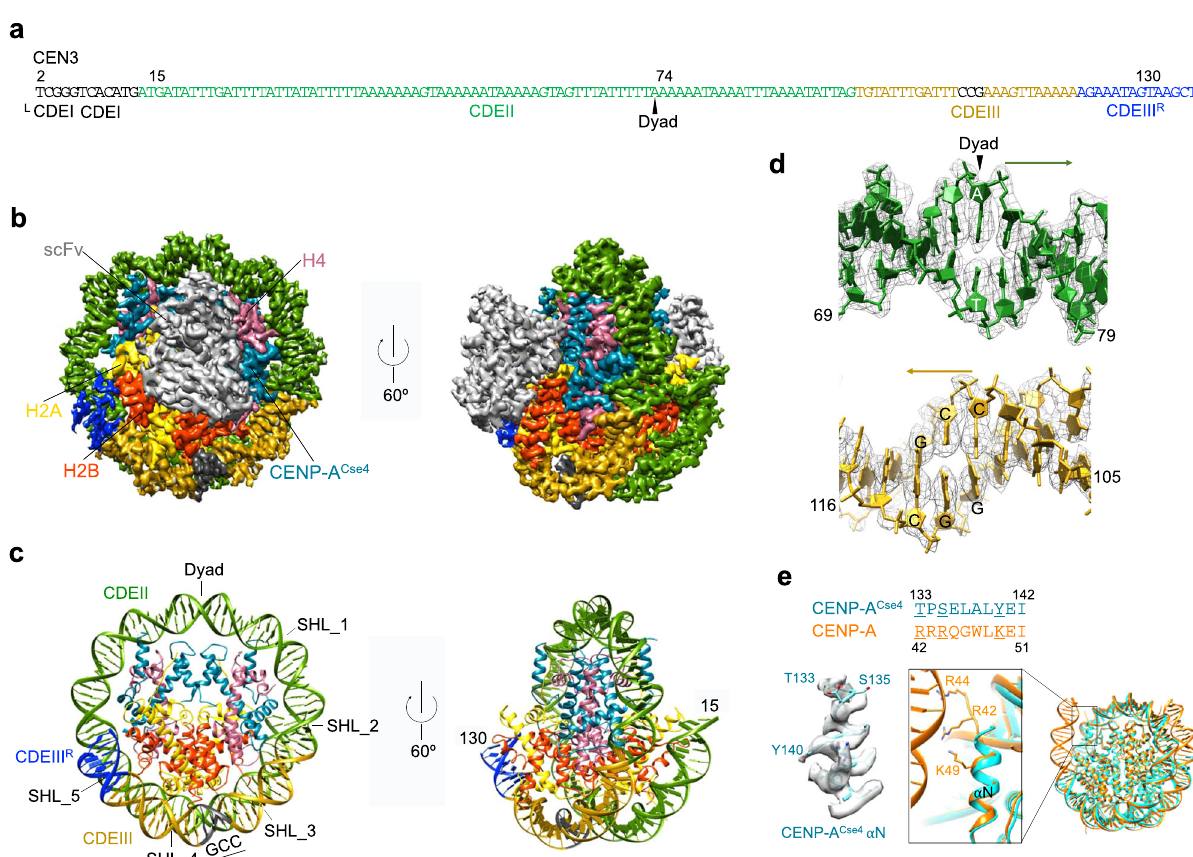
Fig. 1 Cryo-EM Structure of the CEN3 CENP-A Cse4 Nucleosome. a The CEN3 DNA sequence with highlighted speci fi ed regions. b Density maps of the CEN3 CENP-A Cse4 nucleosome bound to scFv in top (left) and 60 o rotational (right) views. c The structures of the CEN3 CENP-A Cse4 nucleosome with the views as in b . d Density maps and structures for the dyad and CCG regions. Arrows indicate the direction of the DNA sequence as in a . e Density map of the α N helix of CENP-A Case4 in the CEN3 nucleosome (cyan) and structural comparison with the corresponding region in human CENP-A nucleosome (orange, PDB: